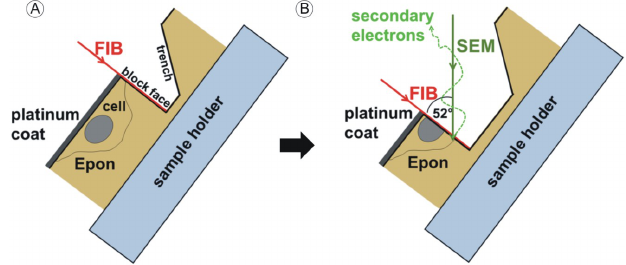
Figure 1. Sample manipulation by the focused ion beam (FIB) and image acquisition with the scanning electron microscope (SEM) beam. Sample preparation is described in [39]. Embedded HCMV infected fibroblasts are located directly under the surface of the approximately 1 mm high Epon block. The sample is coated with a thin platinum layer prior to mounting into the dual beam microscope. The area of interest is chosen at 10 kV acceleration voltage. ( A ) The sample is then tilted to 52° and a trench is FIB-milled into the Epon block, generating a new surface (block face); ( B ) Removal of the next thin layer (“slice”) of the sample generates a new block face. After every “slice” step the generated block face is imaged by the scanning electron beam (“view”). The “slice and view” cycle is repeated to gain a three-dimensional dataset of the volume of interest. Reprinted from [38] Figure 1 with kind permission from Springer+Business Media.